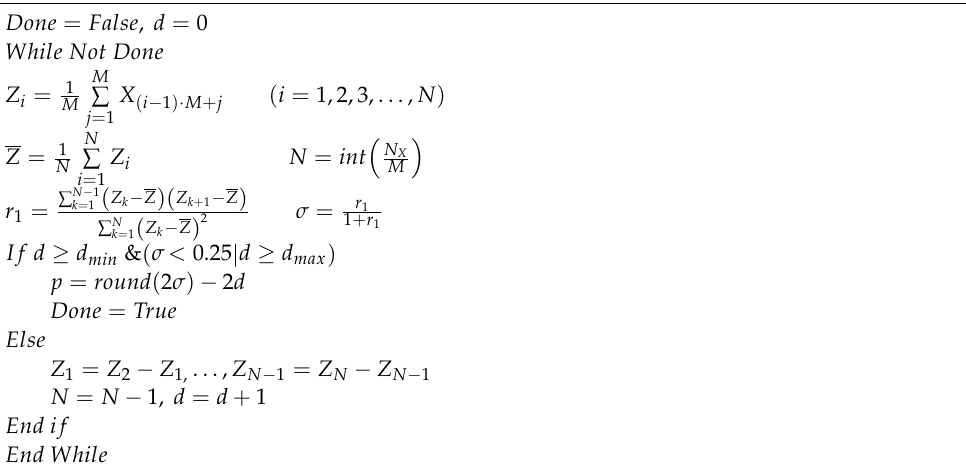
Algorithm 1. Flowchart of lag1 ACF algorithm for noise identification.